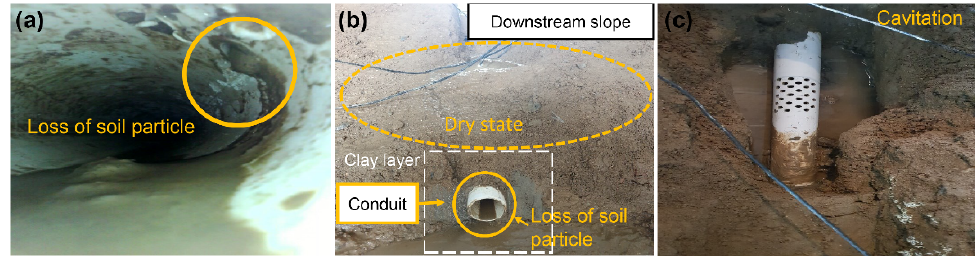
Figure 3. Crack conditions in current model (Case 1—Crack): ( a ) soil particle loss inside conduit, ( b ) surface conditions of downstream slope, ( c ) erosion in near-conduit-filling zone.